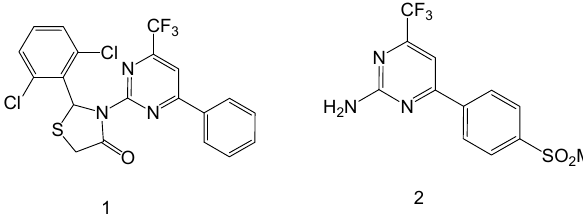
Figure 1. 2-amino-4-phenyl-6-trifluoromethyl pyrimidine class of compounds.